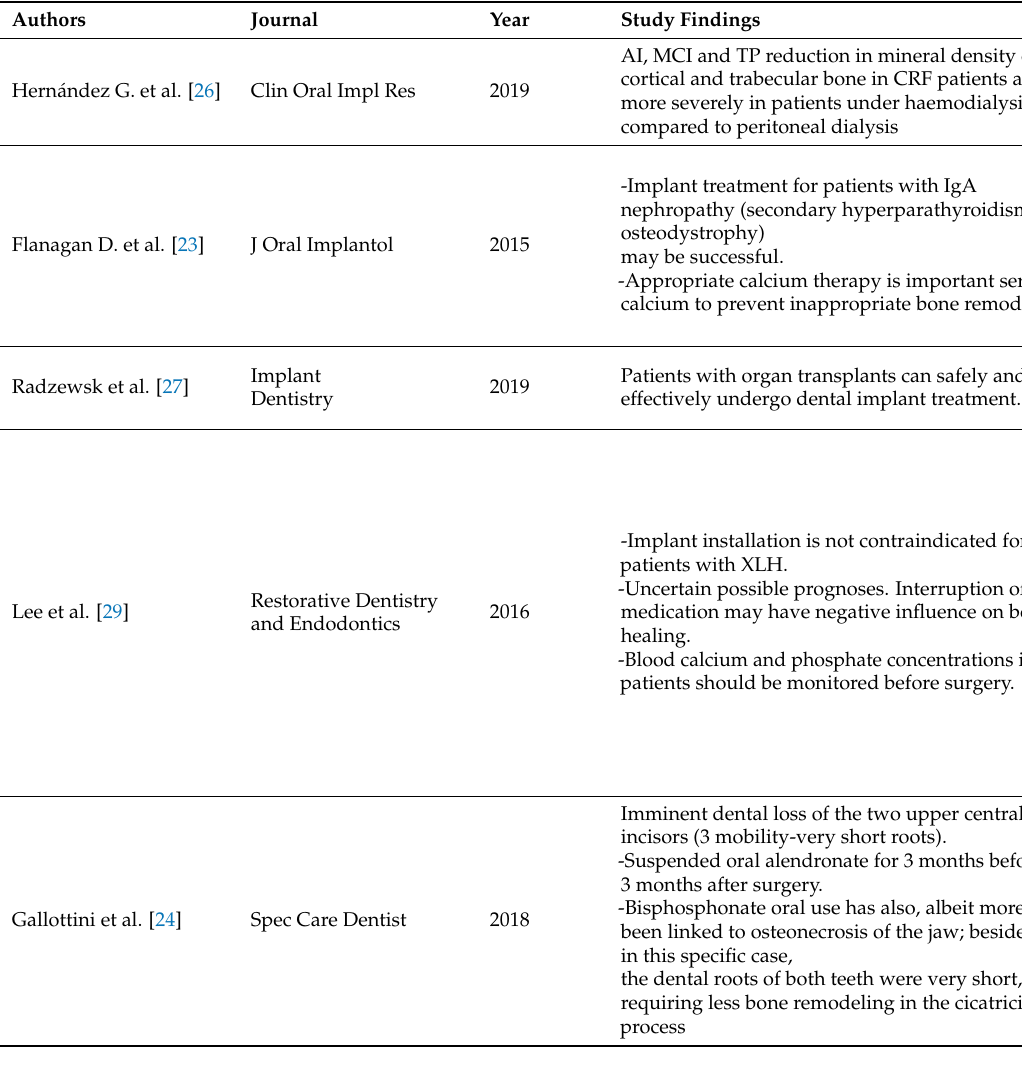
Table 4. Descriptive summary of included studies [Auth, Journal, Year, study findings, Implant failure, Follow up, Renal